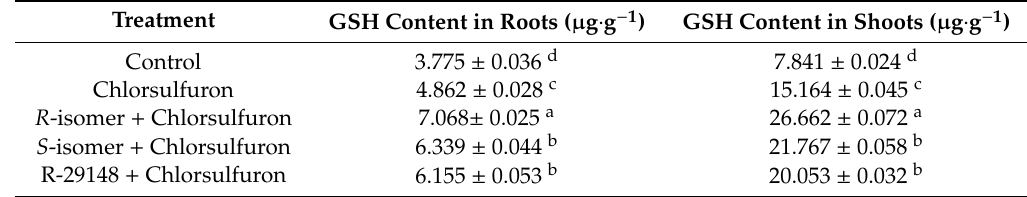
Table 1. E ff ects of safeners and chlorsulfuron on the glutathione (GSH) content in maize.